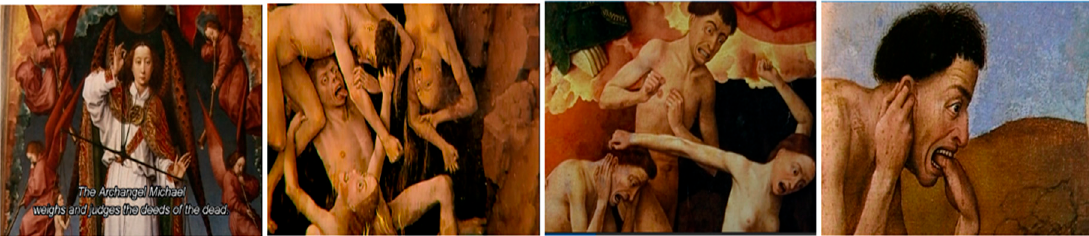
Figure 8. ( a ) Varda’s focus on signs of ageing; ( b – d ) Damps stains on the walls and ceiling of her apartment which she imagines as works of art of established artists.